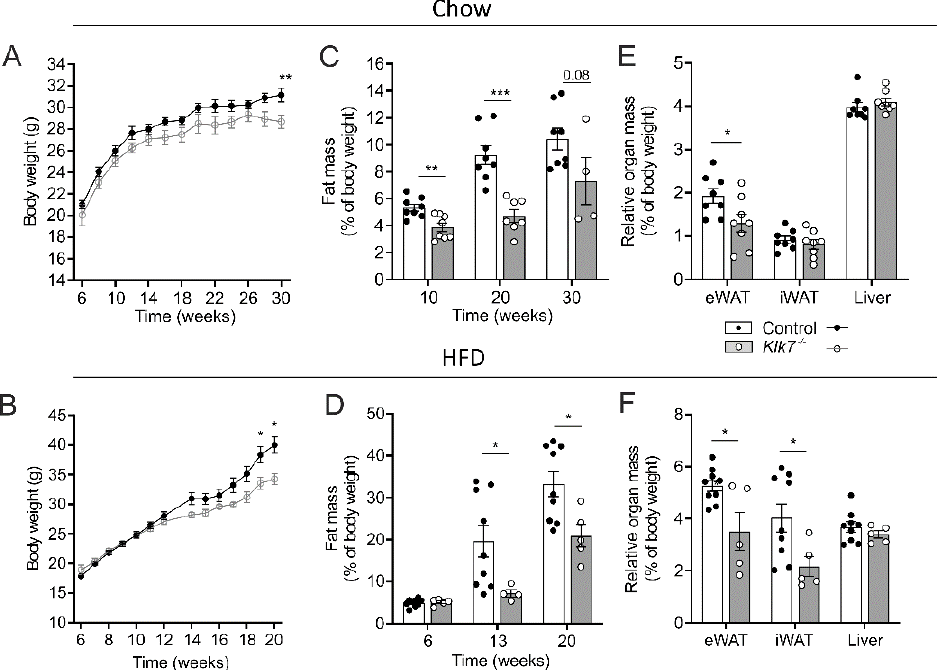
Figure 1. Body weight development and body composition of Klk7 − / − deficient mice under chow and high fat diet. ( A , B ) Body weight gain under chow and HFD for Klk7 − / − ( n = 8/5 chow/HFD) and control mice ( n = 8/9 chow/HFD). Weight gain is significantly reduced for Klk7 − / − mice under both diets. ( C , D ) MRI scans reveal a significant reduction in total fat mass (presented as % of body weight) for Klk7 − / − mice beginning at an age of 10 weeks and independent of the diet. ( E , F ) Determination of relative organ weights show that Klk7 − / − mice under chow diet exhibit decreased eWAT fat mass compared to chow-fed control mice, while HFD-fed Klk7 − / − mice have both reduced eWAT and iWAT fat mass compared to obese controls. Data are presented as means ± SEM; significance was tested by two-way ANOVA with correction for multiple testing (Sidak; A , B ) or multiple t -tests with correction for multiple testing (Holm–Sidak; C – F ); * p < 0.05; ** p < 0.01; *** p < 0.001. Energy expenditure was assessed using indirect calorimetry (Figure 2). While there was no change in oxygen consumption (Figure 2A) and total energy expenditure (EE, Figure 2B) in chow-fed animals, Klk7 − / − mice under HFD showed significantly higher oxygen consumption (Figure 2D) and EE during the light phase compared to controls ( p < 0.05; Figure 2E). Locomotor activity was not affected by Klk7 − / − . Interestingly, Klk7 − / − exhibited a preference for carbohydrate oxidation reflected by significantly higher respiratory exchange ratios (RER) compared to controls (Figure 2C,F). As observed in AT Klk7 − / − mice [16], food intake was higher in Klk7 − / − mice, both under chow and HFD (Figure